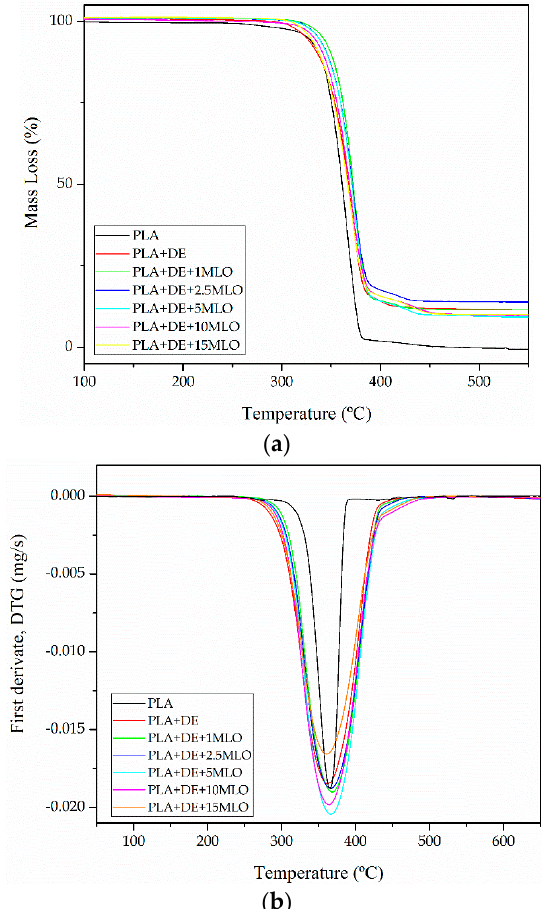
Figure 3. Comparative thermogravimetric (TGA) plots corresponding to PLA/DE composites with varying MLO content: ( a ) TGA thermograms curves and ( b ) first derivative, DTG curves.